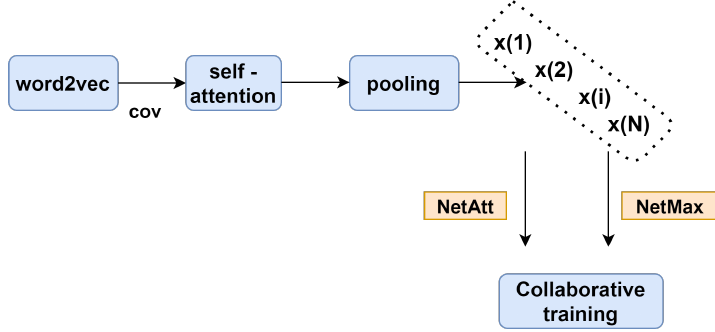
Figure 2. The overall architecture of the collaborative curriculum learning method.